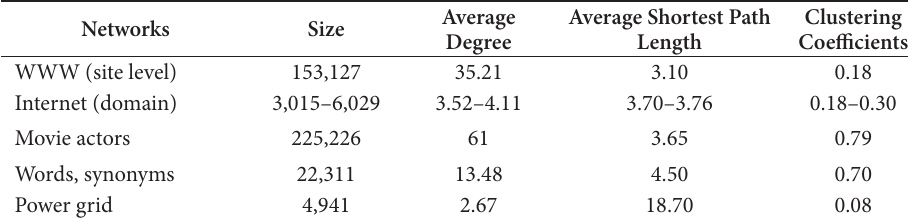
Table 2. Features of the network that have been studied